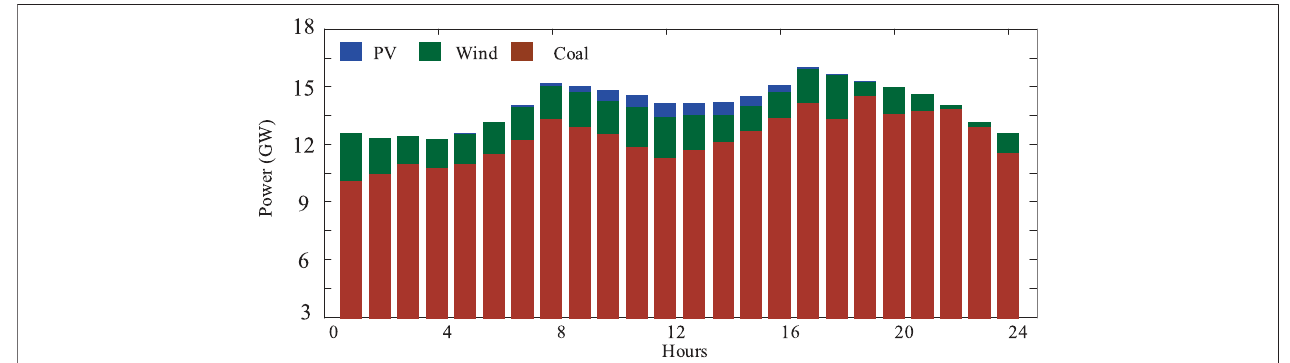
FIGURE 4 | Power components of the Heilongjiang power grid on a typical winter day under in baseline scenario.